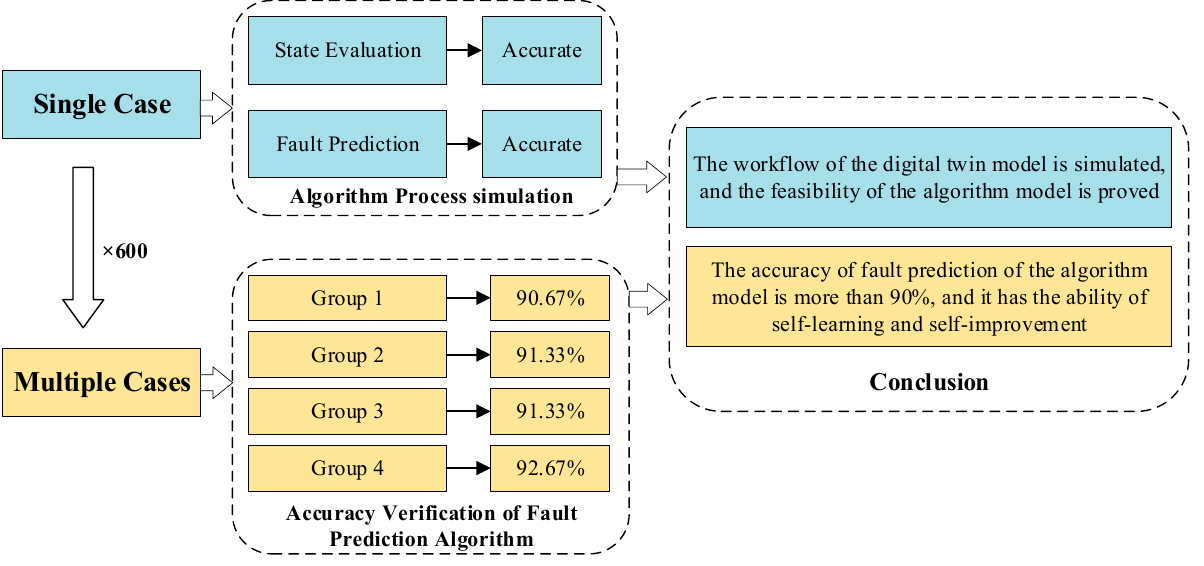
Figure 7. Schematic diagram of case analysis.